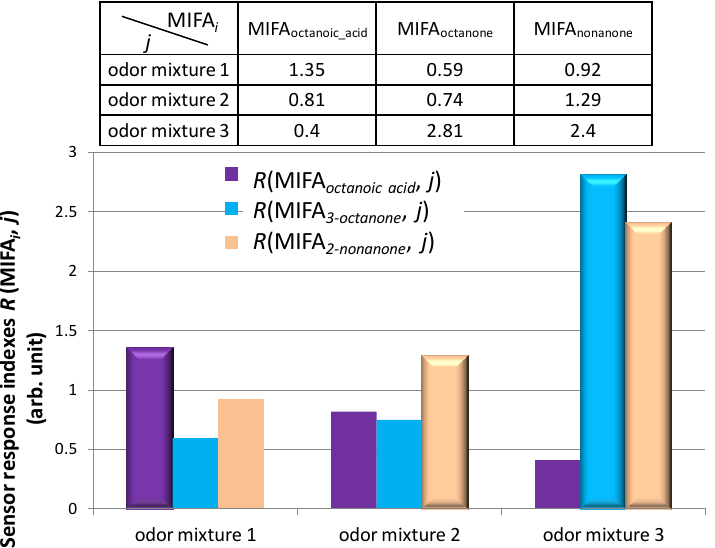
Figure 10. The sensor response index R (MIFA odor-separating system with different embedded